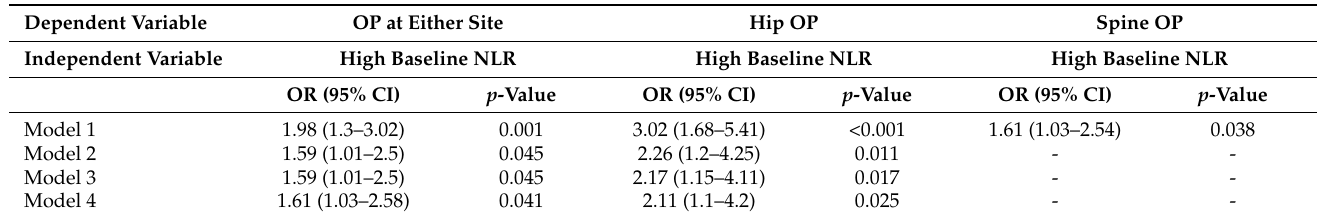
Table 4. Association between baseline neutrophil-to-lymphocyte ratio and osteoporosis in patients with rheumatoid arthritis evaluated by logistic regression models.